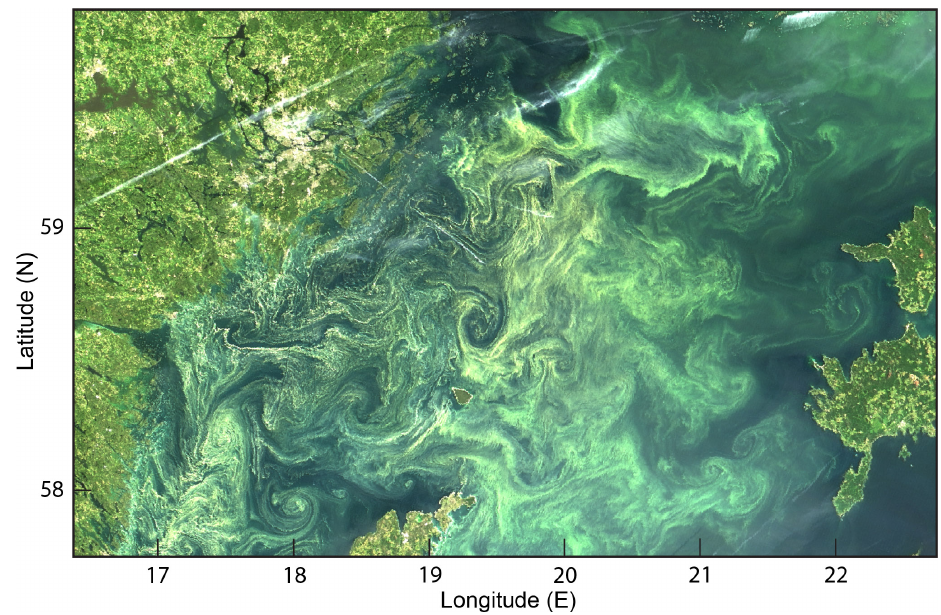
Figure 1. Cyanobacteria (primarily Nodularia spumigena ) accumulations in Northern Baltic Proper on 11 July 2005 as shown on MODIS- Terra quasi true color image at 250m resolution using bands 1 (red), 4 (green), and 3 (blue). Straight white lines are aircraft